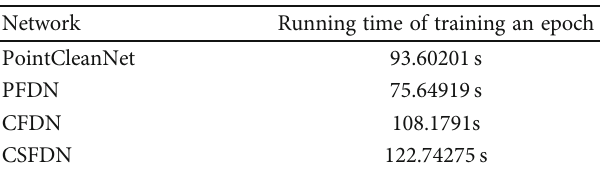
Table 4: Quantitative comparison of training time, the batchsize for training is 64.